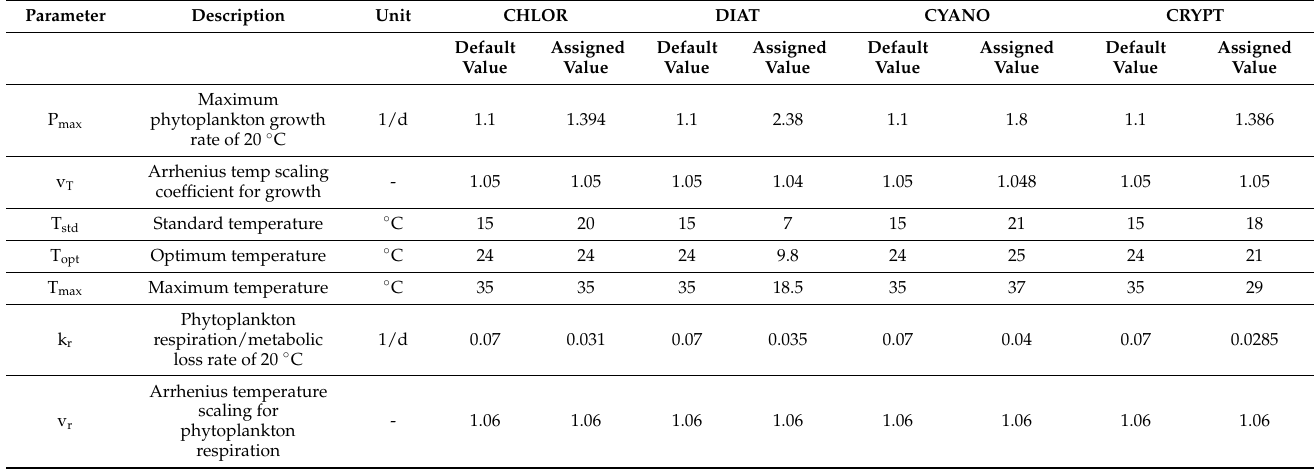
Table A4. Adjusted phytoplankton parameters in